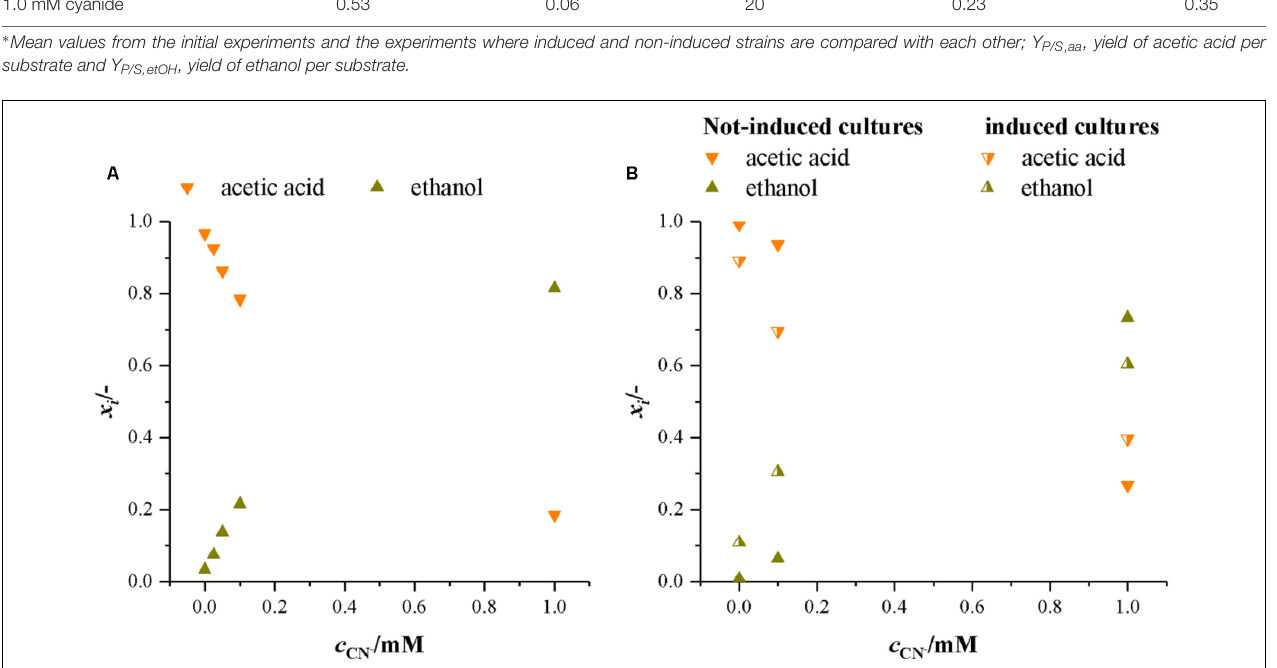
FIGURE 6 | Molar ratio of products formed by C. ljungdahlii in the presence of increasing concentrations of cyanide with fructose as a carbon source. Average data from three different cultivations. (A) Experiments with non-induced cultures only. (B) Experiments with non-induced and induced cultures. Orange, upturned triangles, acetic acid and dark yellow triangles,